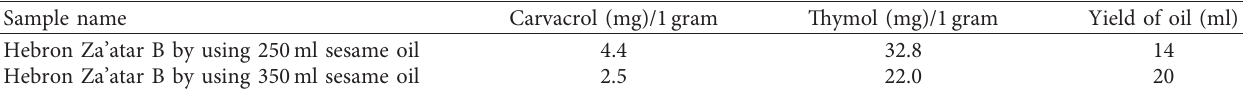
Table 5: Thymol and carvacrol content and yield when the volume of sesame oil is